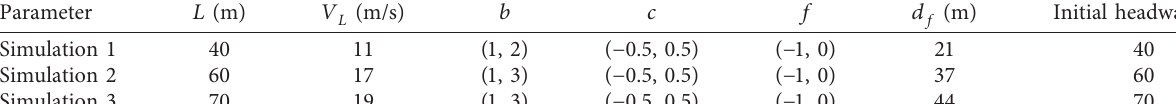
Table 1: The parameters in the car-following model of